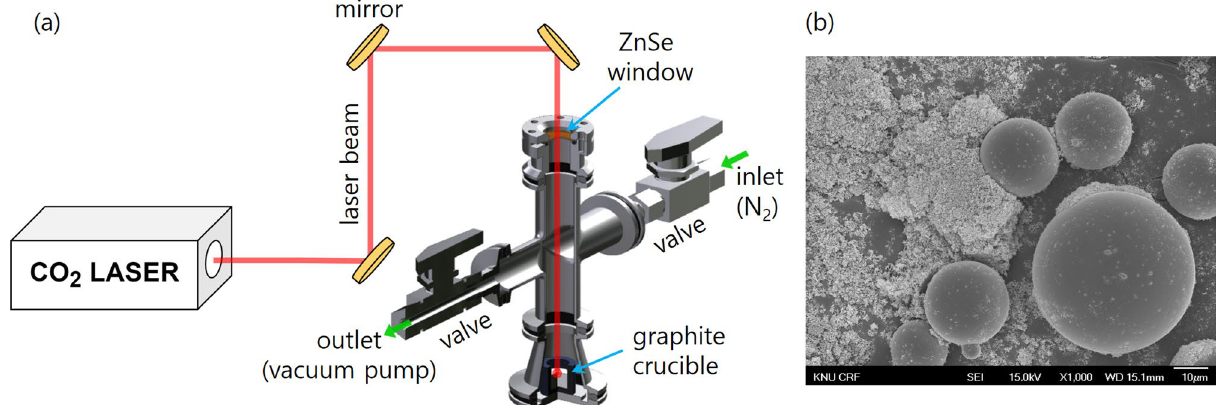
Figure 1. ( a ) A schematic of the experimental setup and ( b ) a SEM image of the pristine mixture.